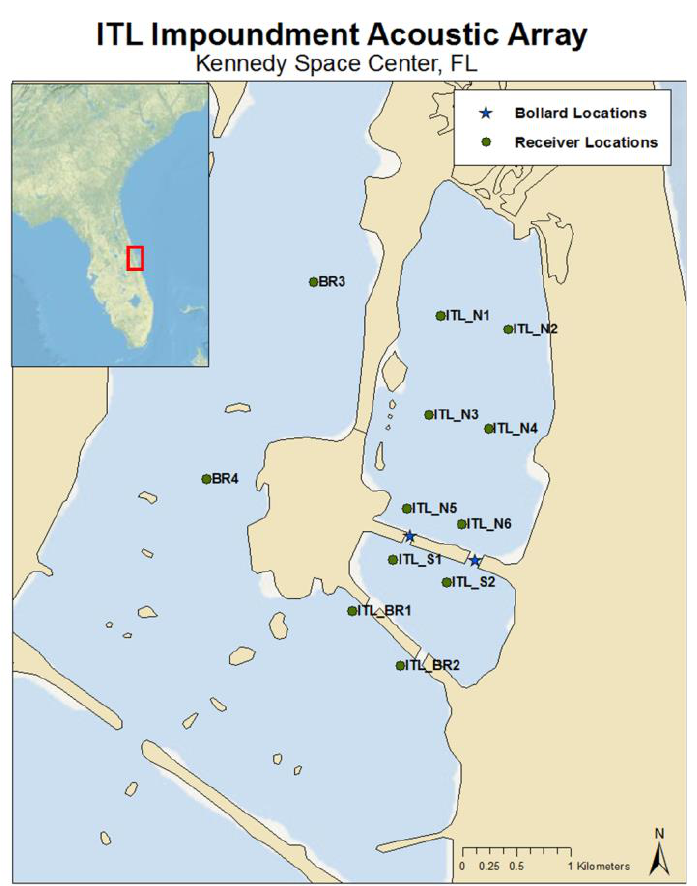
Figure 1. Location of acoustic receivers within the Integrate-Transfer-Launch (ITL) complex and impoundments (north and south) located in the northern Banana River along the central east coast of Florida with the location of acoustic receivers (green dots) and bollards (blue stars). HOBO temperature loggers deployed on ITL_N2, ITL_N5, ITL_S1, and ITL_BR2. Inset map depicts location of the ITL focal study area within Florida (~28°32′ N 80°35′ W), in the southeastern USA.